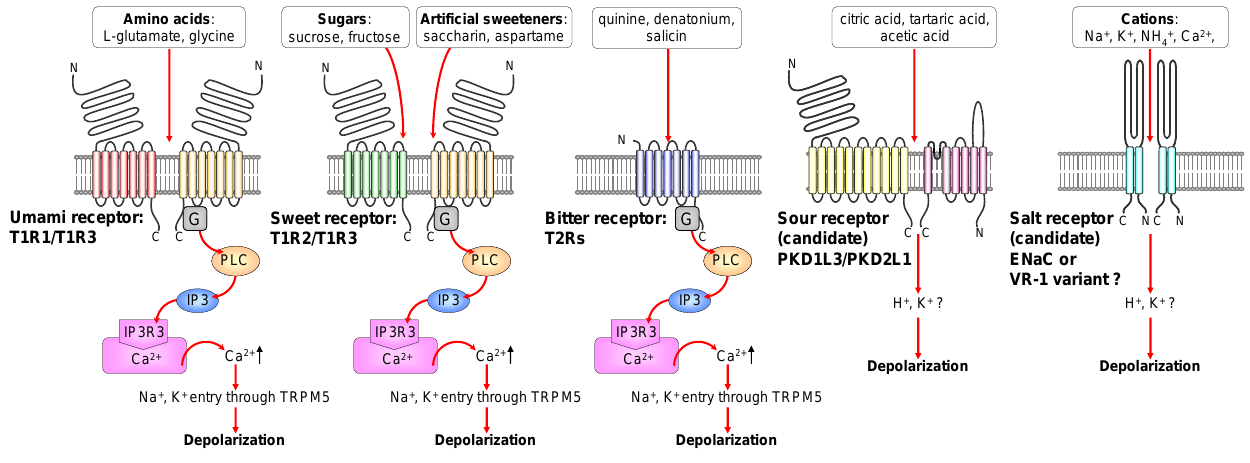
Figure 1. Taste receptors for five basic taste qualities and signal transduction pathways. G, GTP-binding protein; PLC, phospholipase C-type β 2; IP3, inositol 1,4,5-trisphosphate; IP3R3, 1,4,5-trisphosphate receptor type 3; TRPM5, transient receptor potential cation channel, subfamily M, member 5. For details, see references